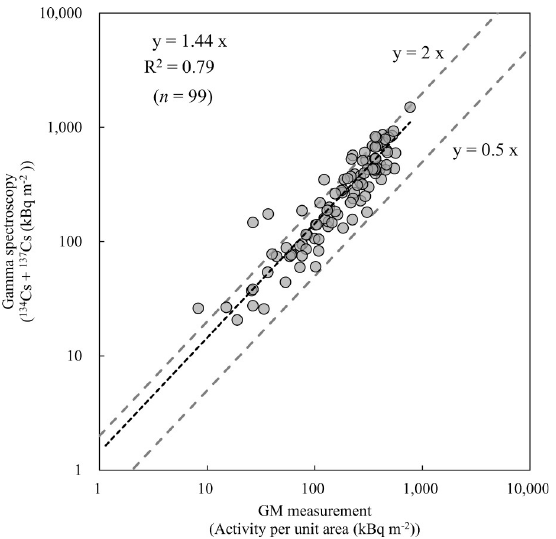
Fig 4. The relationships between the radiocaesium inventory by gamma spectroscopy and the inventory by GM